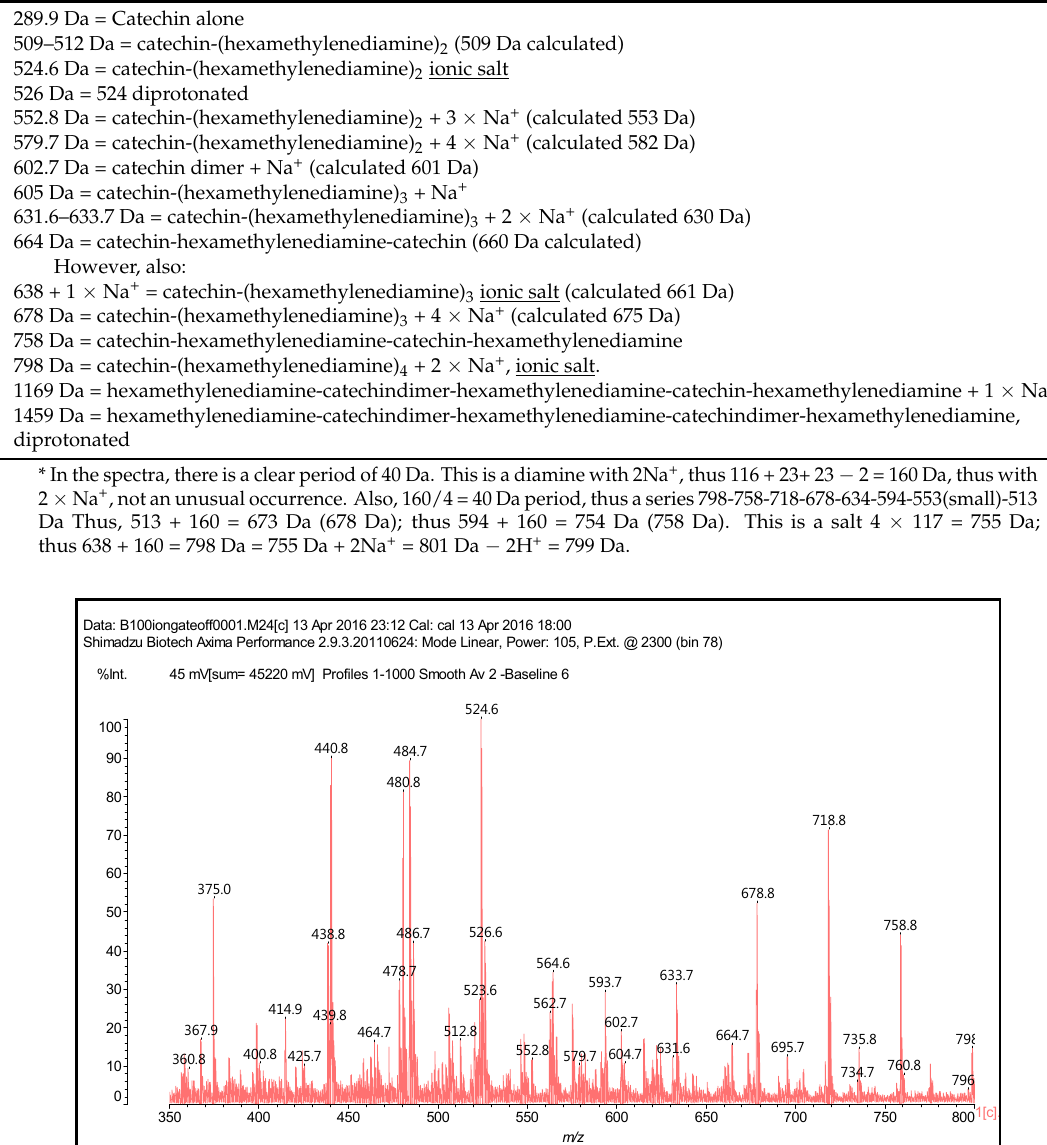
Table 1. MALDI-ToF peaks interpretation. NaOH-catalysed reaction of catechin and hexamethylenediamine at 100 °C *.